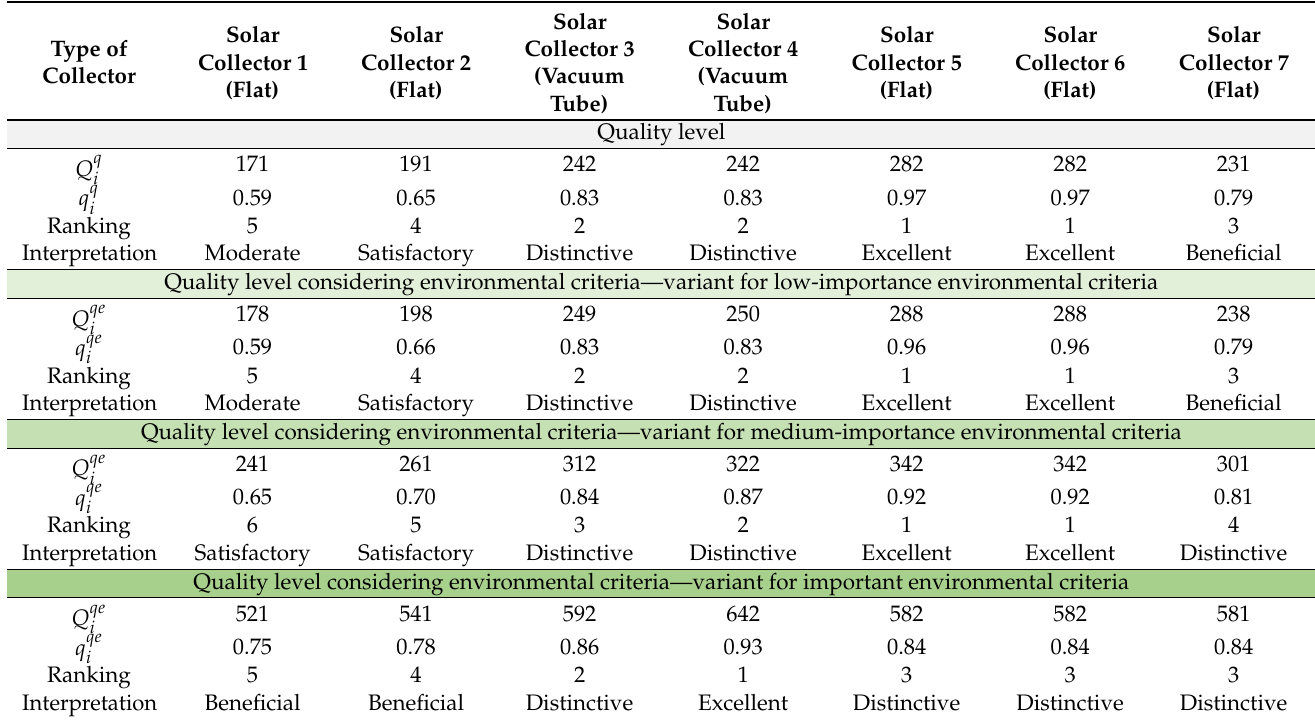
Table 4. Result of MAP method for quality level and qualitative–environmental level of solar